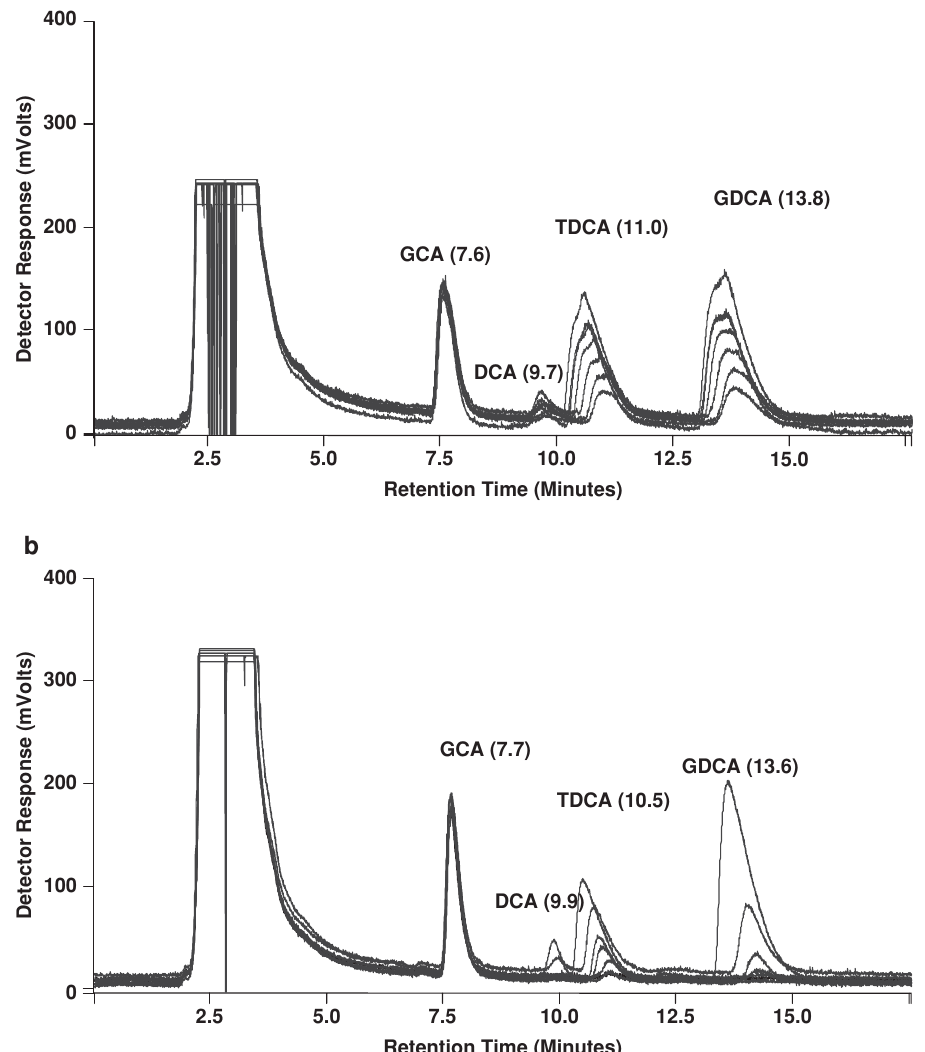
Figure 5 (a) Overlaid HPCL chromatograms of samples (0 h, 1 h, 2 h, 3 h, 4 h, 5 h, 6 h) from an experiment in which immobilized LP80 (pCBH1) was used to deconjugate 10 mM GDCA and 5 mM TCDA in MRS reaction media. (b) Overlaid HPLC chromatograms from a calibration with increasing concentrations (2 mM, 3 mM, 4 mM, 6 mM, 7 mM, 8 mM, 10 mM) of TDCA GDCA and DCA. A 4 mM internal standard was used for the preparation of all samples.